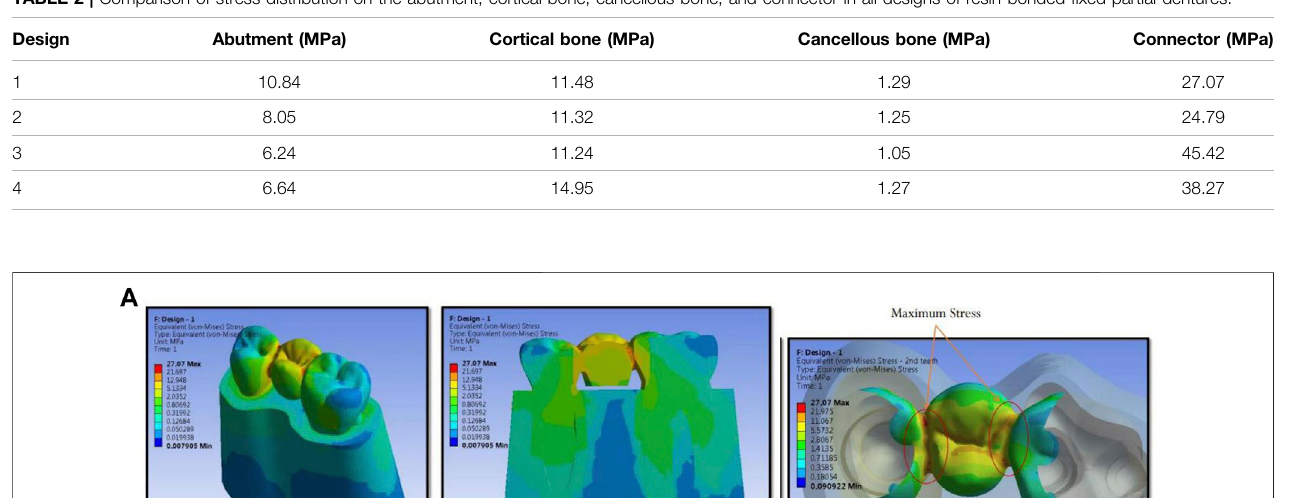
Frontiers in Bioengineering and Biotechnology |